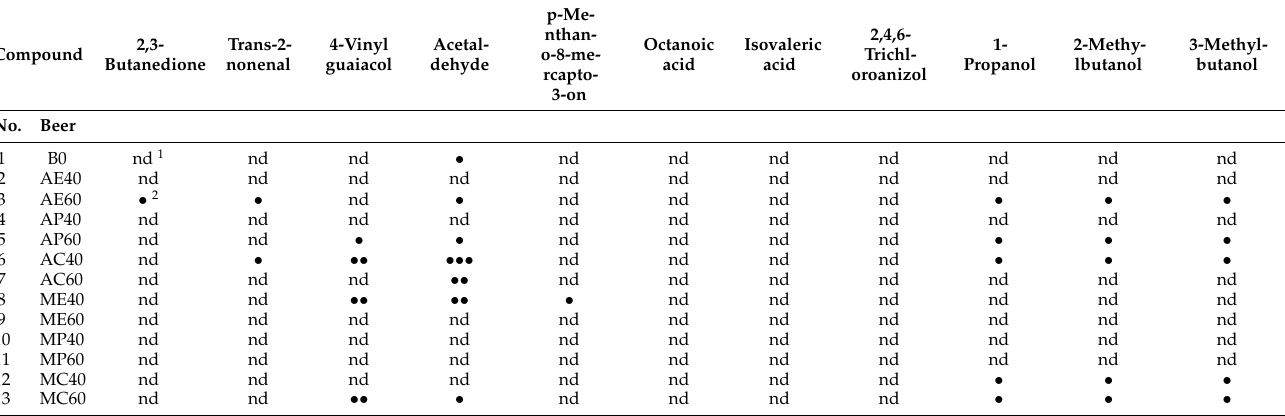
Table 5. Volatile compounds indicative of beer